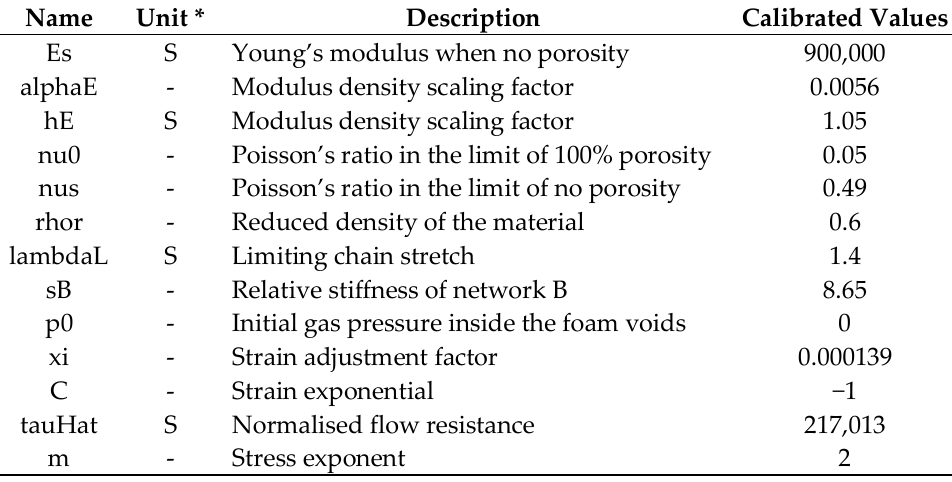
Figure 2. Cyclic loading of the BB shockpad for ( a ) test condition A and ( b ) test condition B. Table 1. Material parameters and values calibrated by the Micromechanical foam